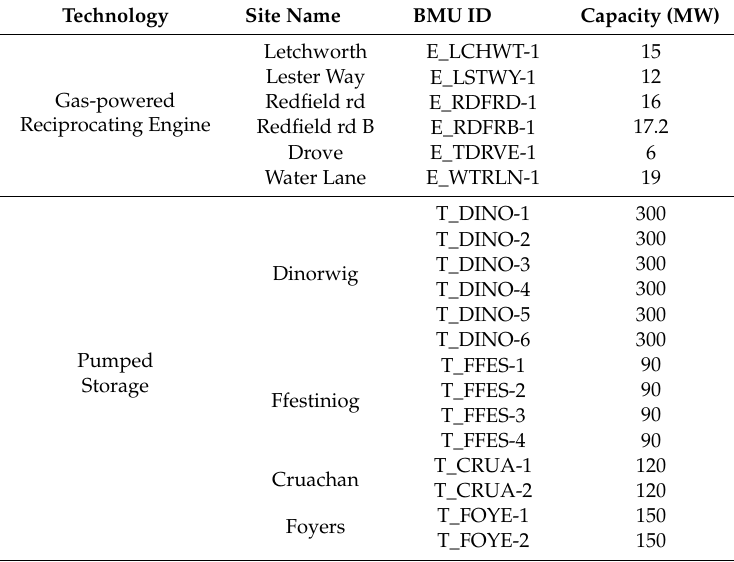
Table 2. Units for comparison extracted from ELEXON